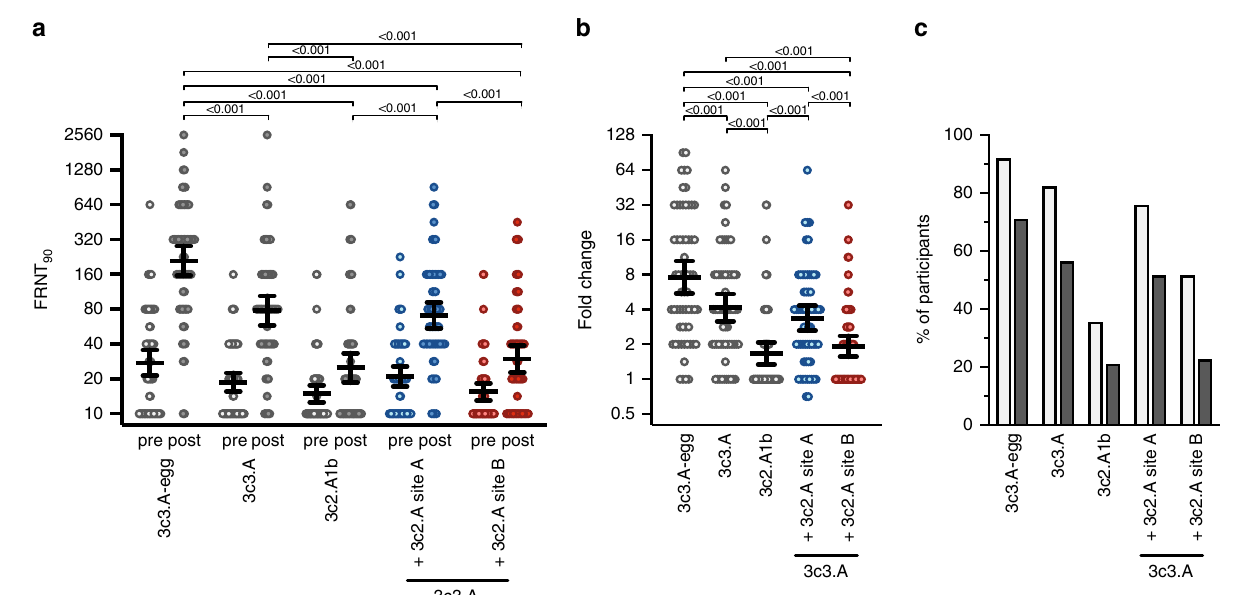
Fig. 2 Neutralizing antibody titers (FRNT 90 ) to a panel of H3N2 viruses in sera from adults ( n = 62) who received the 2019 – 2020 Northern Hemisphere in fl uenza vaccine. a Pre- and post-vaccination titers. Each data point represents the geometric mean titer from two independent experiments. Thick horizontal lines show the geometric means and error bars indicate the 95% con fi dence intervals. Log 2 -transformed antibody titers were compared using RM one-way ANOVA corrected for multiple comparisons (Bonferroni method). P -values < 0.05 are indicated. b Fold change of geometric mean neutralizing antibody titers (FRNT 90 ) upon vaccination. Post-vaccination titers were divided by pre-vaccination titers to calculate fold change. Thick horizontal lines show the geometric means and error bars indicate the 95% con fi dence intervals. Log 2 -transformed antibody titers were compared using RM one-way ANOVA corrected for multiple comparisons (Bonferroni method). P -values < 0.05 are indicated. c Seroconversion rates upon vaccination. Light gray bars indicate at least a twofold increase in antibody titer. Dark gray bars indicate at least a fourfold increase in antibody titer. 3c3.A virus with 3c2.A site A possesses amino acid substitutions A128T, S138A, G142R, and K144S. 3c3.A virus with 3c2.A site B possesses amino acid substitutions S159Y, K160T, and S193F. Source data are provided as a Source Data fi